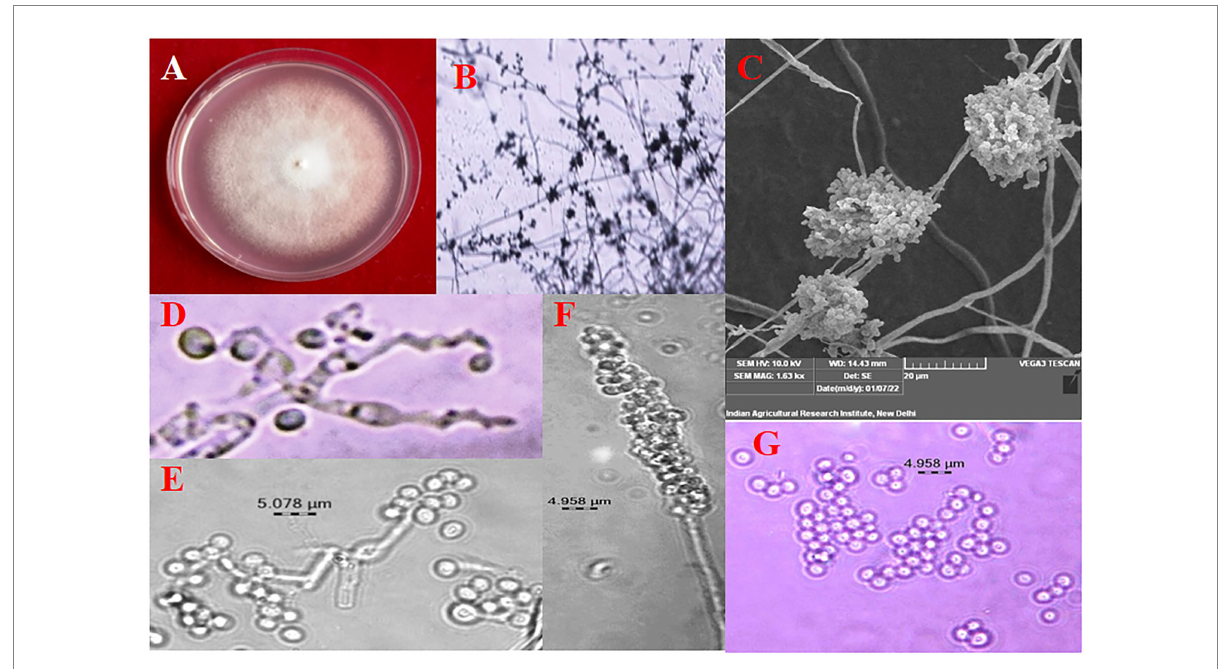
FIGURE 1 Morphological Characterization of B. bassiana (A) colony on PDA, (B) conidiophore branching under 10X, (C) conidial cluster under SEM, (D) elongated sympodial rachis, (E) and (F) conidia production on rachis, (G)